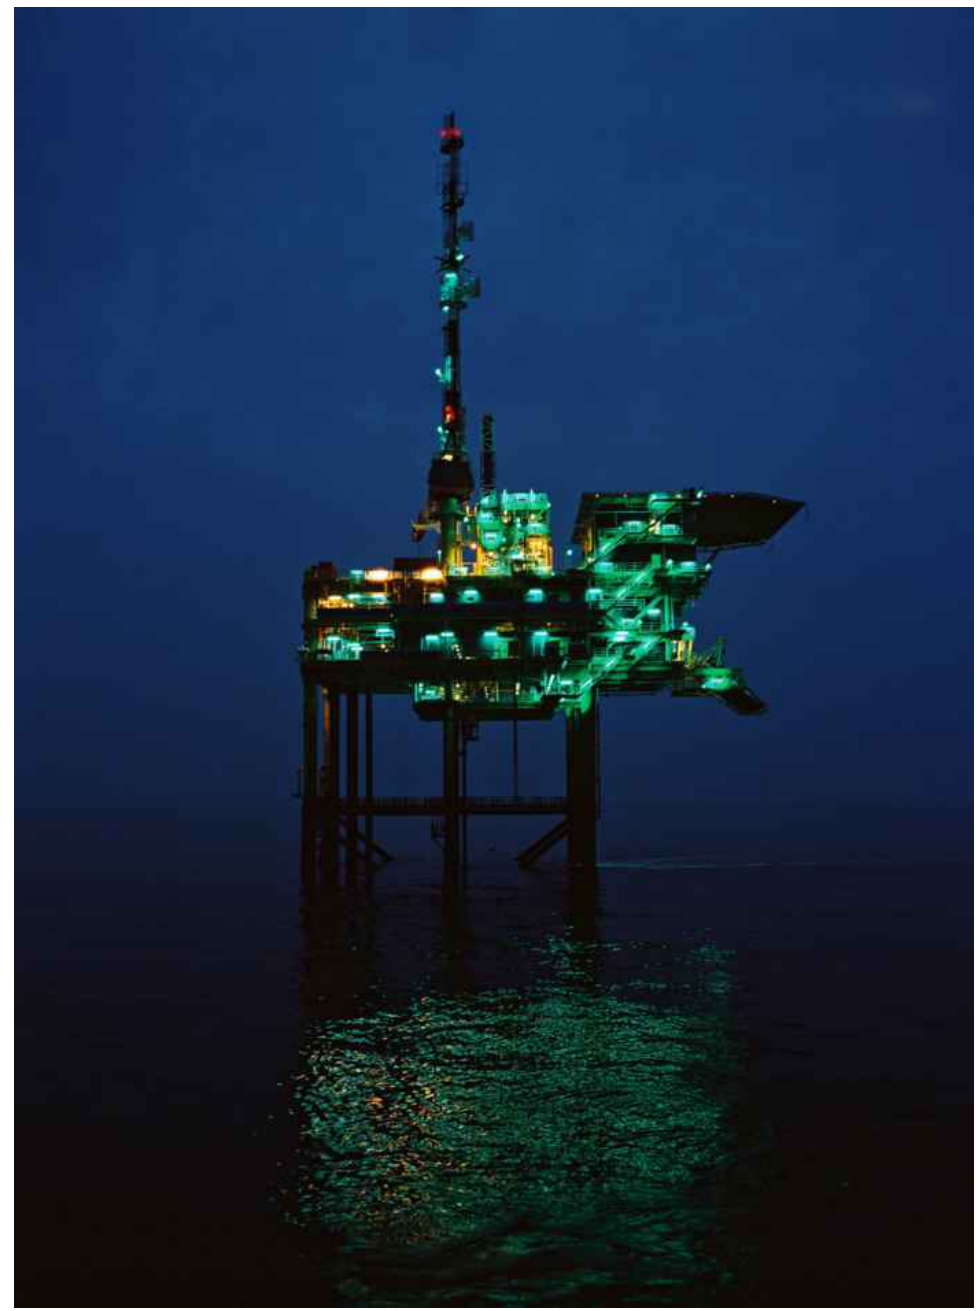
Fig. 6. Photo of the Nederlandse Aardolie Maatschappij (NAM) offshore gas-production platform L15, situated in the North Sea about 20 km offshore of the barrier island Vlieland (photo courtesy NAM), after our light-color recommendations were acted upon. At the time of the photo, some of the white lights still needed to be replaced by green